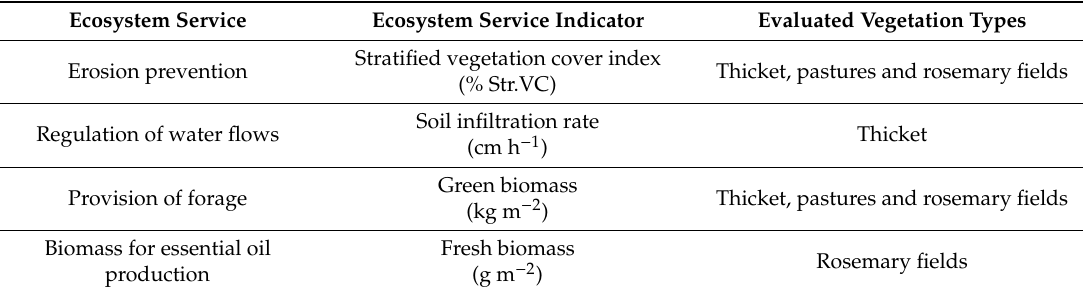
Table 1. Ecosystem services evaluated in the study area. Str.VC: Stratified vegetation cover.